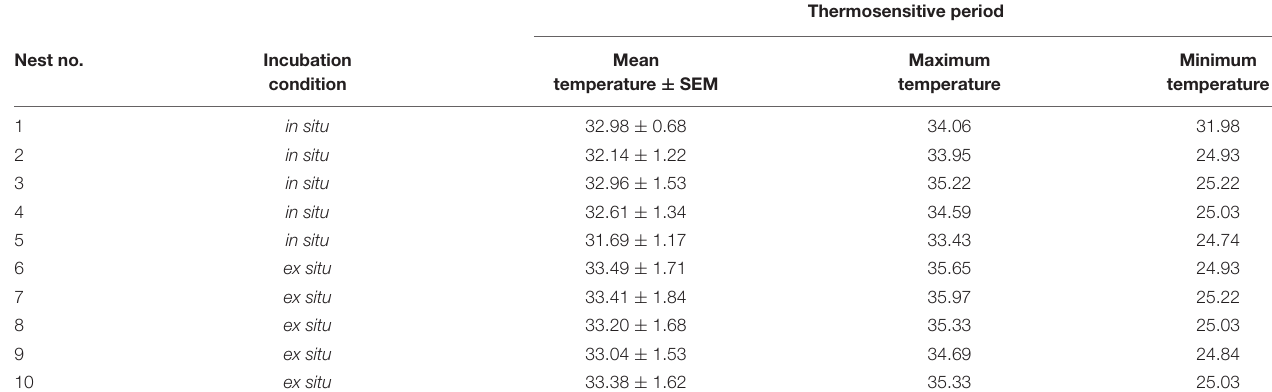
Figure 5 and Table 2 ) in comparison with ovaries from ex situ offspring. The best model for ovarian cell proliferation explained 89% of the data variation ( Table 2 ). Cell density